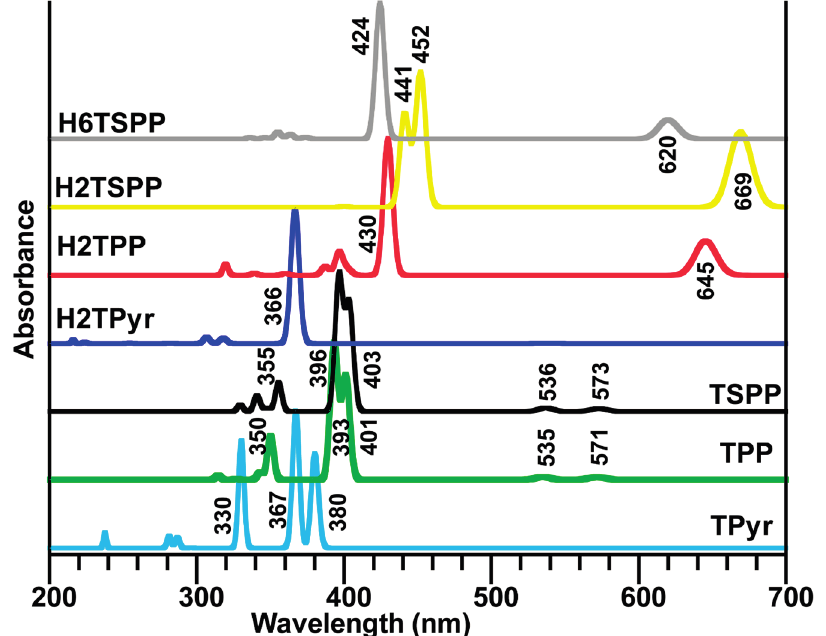
Figure 5. Calculated dipole allowed electronic transitions of porphyrin derivatives in water used as a solvent in the calculations at the TD-B3LYP/6-31G(d,p) level of the TD-DFT: free-base porphyrin (TPyr), meso -tetraphenylporphyrin (TPP), dianionic meso-tetrakis( p - sulfonatophenyl)porphyrin (TSPP), and protonated-TPyr (H 2 TPyr), protonated-TPP (H 2